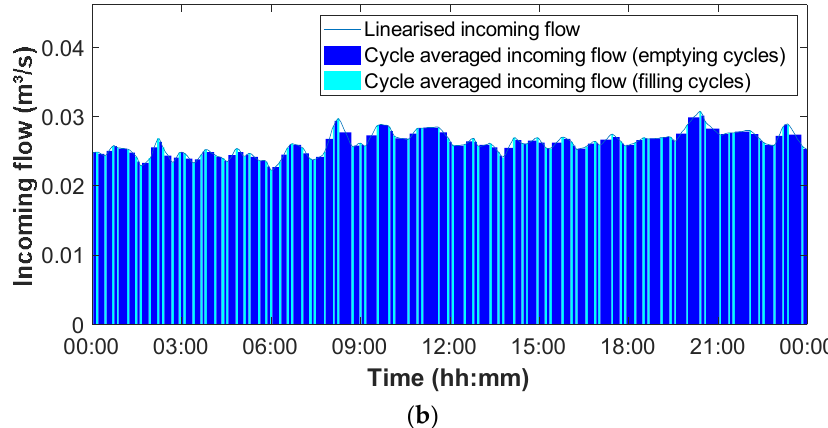
Figure 7. Example of calculated pump flows with pumps of different nominal capacities: ( a ) pumped flows per cycle per pump (top); ( b ) average incoming flows for filling and emptying cycles and linearised flows for all cycles (bottom) (PS Wauberg).